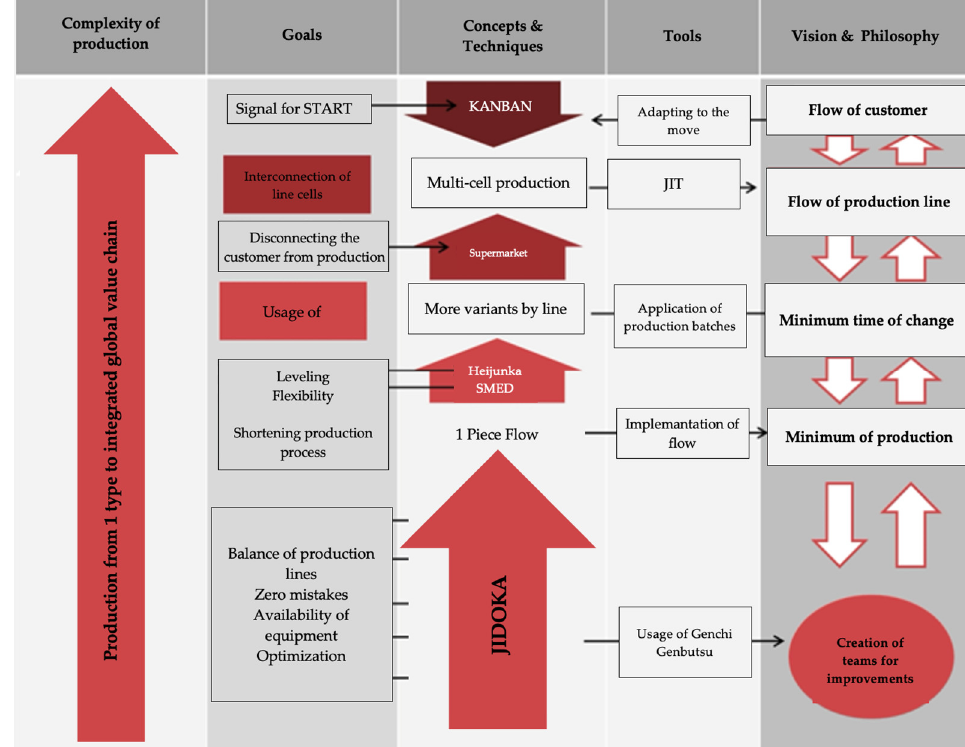
Figure 4. The Toyota production system’s one-pillar diagram (modified). Source: Authors’ compi- lation according to [24].